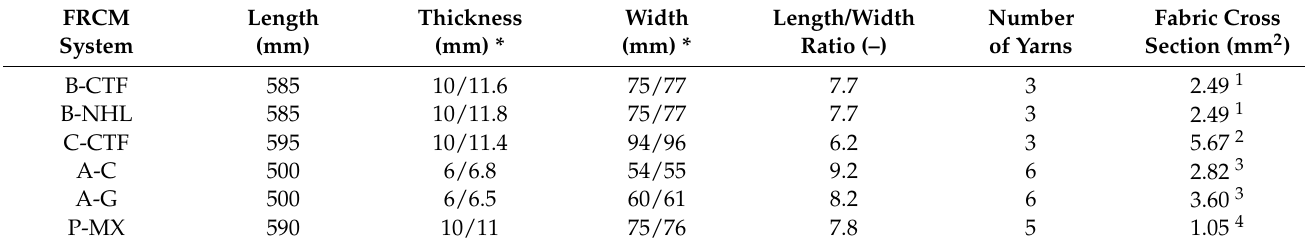
Figure 2. Preparation of the specimens: ( a ) rectangular mould; ( b ) PVC spacer; ( c ) application of the first layer of mortar; ( d ) fabric application; ( e , f ) application of the second layer of mortar; ( g ) fresh mortar covered with PVC film; ( h ) cutting out specimens; ( i ) application of the glass grid reinforced polyurethane PS layer on the ends of the specimens. Table 4. Geometry of the specimens.